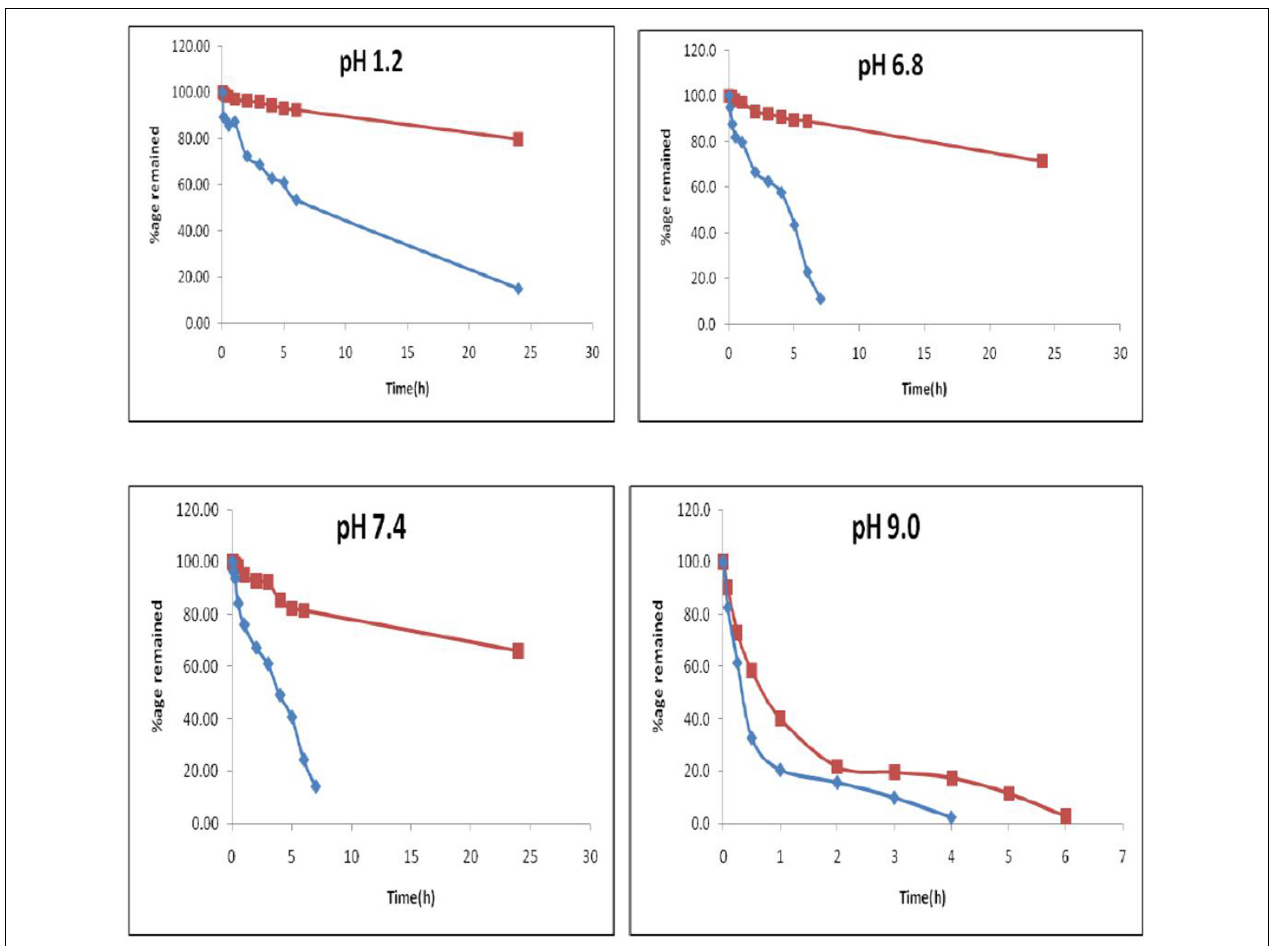
FIGURE 5 | Percentage remaining of curcumin versus time plot at various pH.